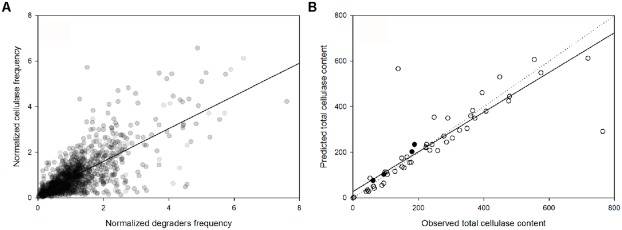
(A) Linear dependence of the normalized abundance of potential cellulose degraders and their potential cellulase content, across the samples (PSpearman < 0.01). (B) Comparison between the observed and the predicted cellulase content based on microbial community composition [samples used to construct the linear regression model (○) and independent samples from the factorial reduced precipitation and added nitrogen treatment (●)]. The solid and dotted lines are the regression line and the 1:1 line, respectively.